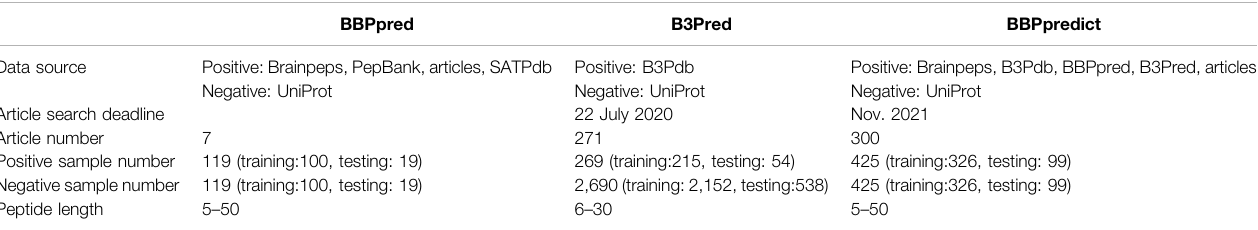
TABLE 4 | Comparison of datasets for three predictors.